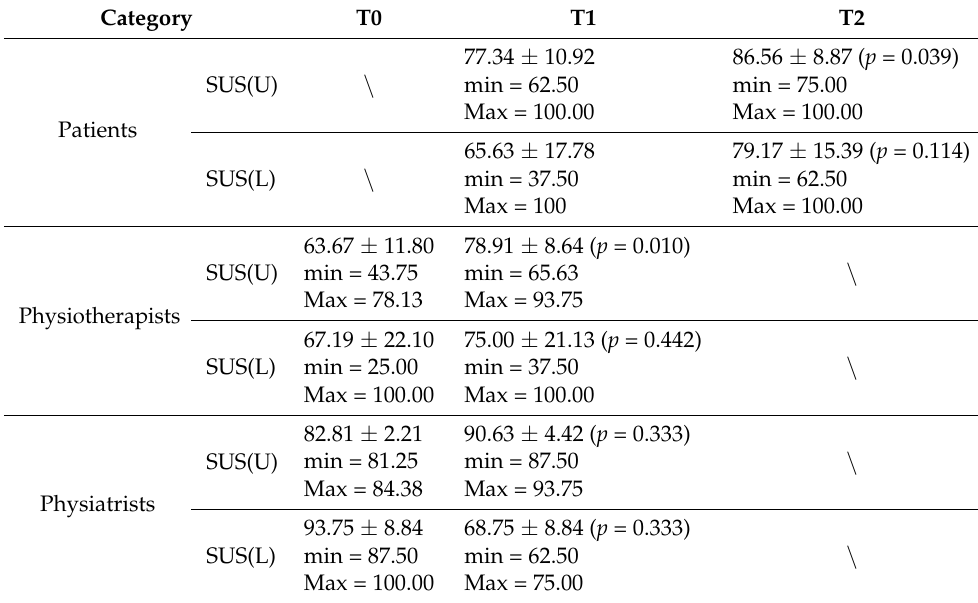
Table 5. SUS(U) and SUS(L) results for groups of